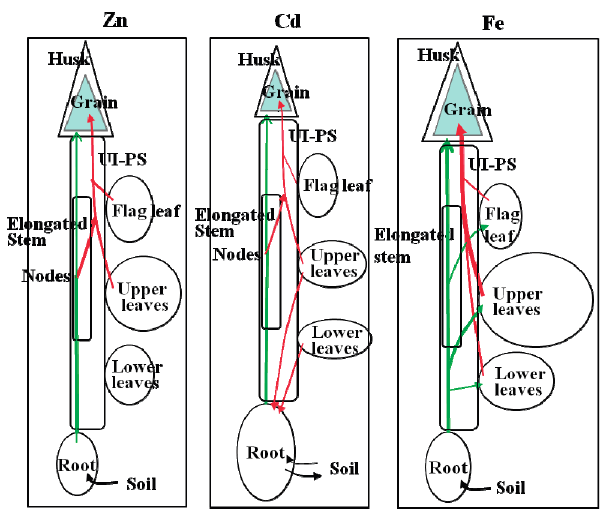
Figure 7. Models of the transport of Zn, Cd, and Fe via xylem and phloem in rice plants at grain filling. “Leaves” are Leaf blades. “Stem” includes elongated culm, leaf sheaths, and panicles except husk and grain. Green line shows xylem transport. Red line shows phloem transport. Phloem sap was collected from the uppermost internode (UI-PS). Information is from Yoneyama et al. [55]. Important note: At the nodes in the elongated stem, Zn and Cd ascending xylem (green line) are transferred to phloem (red line) via the xylem-to-phloem transfer system, while Fe in the xylem (in the form of Fe–citrate) does not pass through this system.